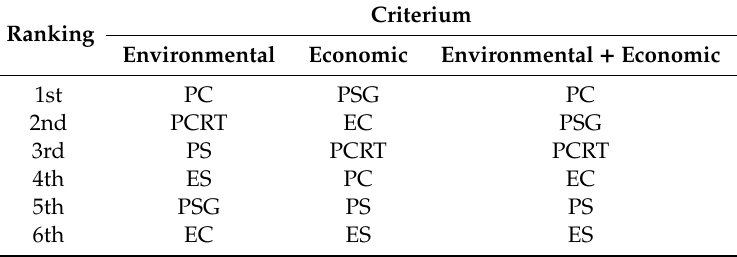
Table 5. Ranking of production systems considering the agricultural and industrial